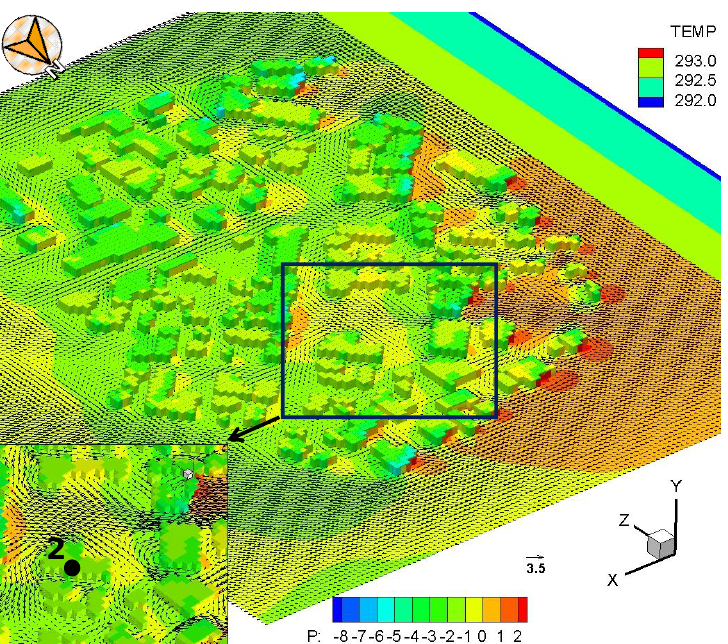
Figure 12. Contours of constant pressure (in Pa on XZ ground plane and building surfaces) and contours of constant temperature (in K on YZ plane). Insert is the region around the building where wind speed measurements were performed (point 2 in Figure 1). Atmospheric conditions corresponding to Pasquil D category (Table 1).